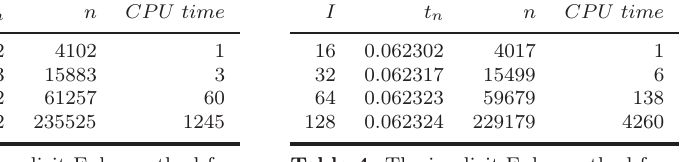
Table 3. The explicit Euler method for ε = 1 / 100 .